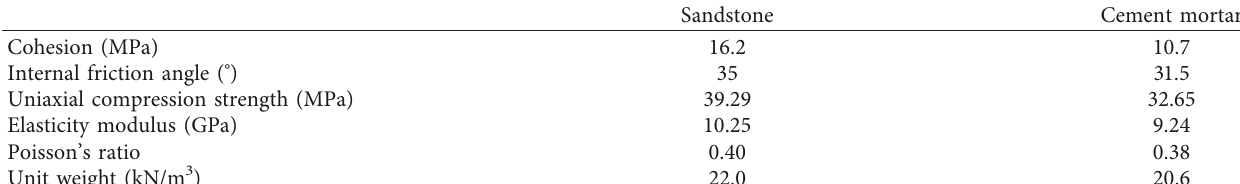
Table 1: The parameter comparisons between sandstone and cement mortar. Sandstone Cement mortar